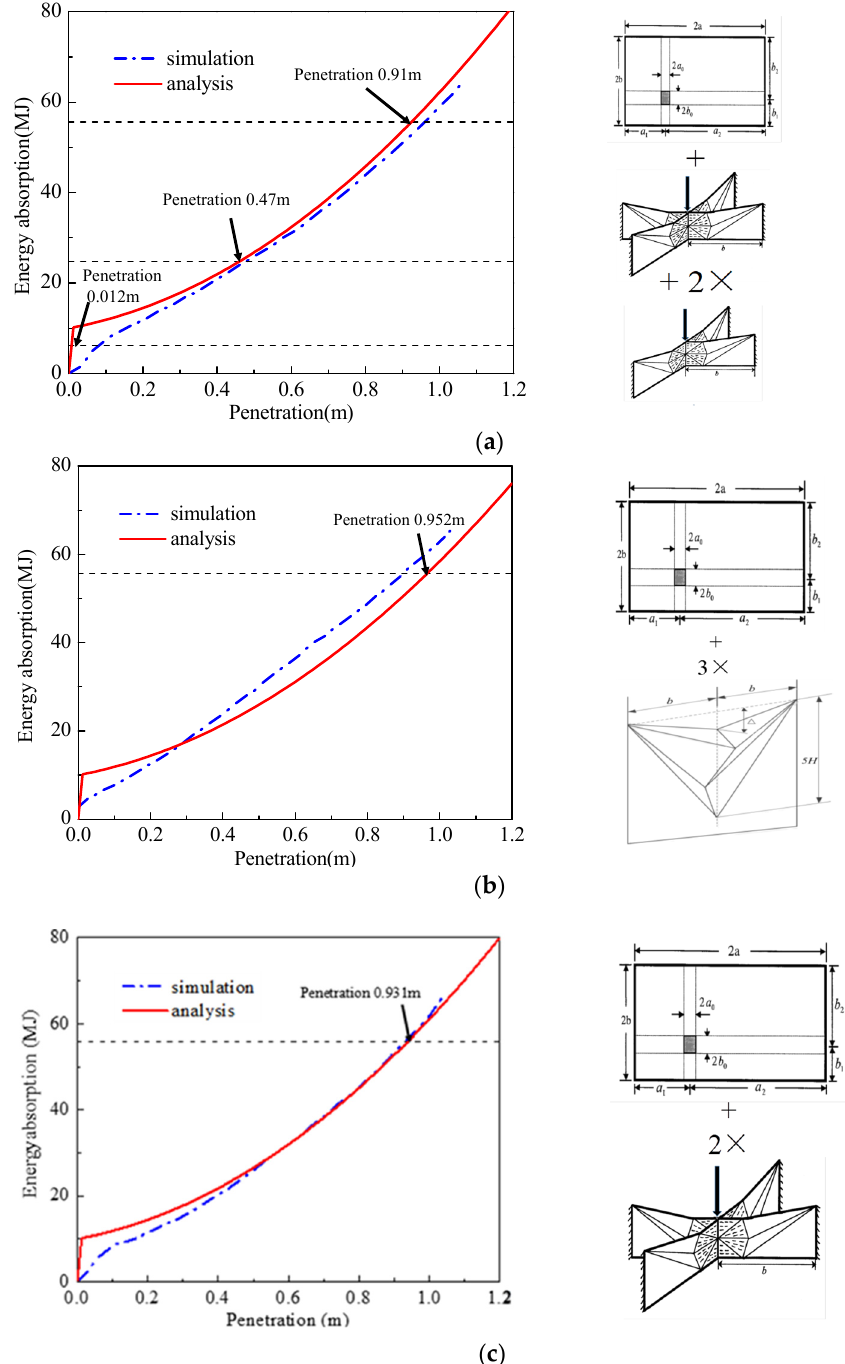
Figure 19. Energy absorption-penetration curves under various collision conditions. ( a ) S-SP1,2,3. ( b ) S-SP4. ( c ) S-SP5.